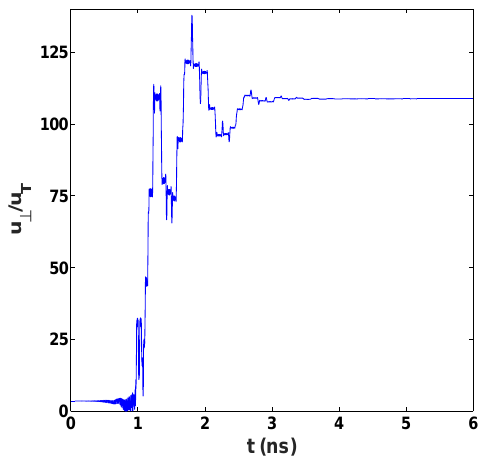
Figure 9. The beam polarization corresponds to the extraordinary EC wave and the beam power is 10 MW. The initial location and magnitude of the parallel ve- locity of the electron are z = 25 cm and u ∥ / u T = − 4, respectively. All the other parameters are as described in the text.